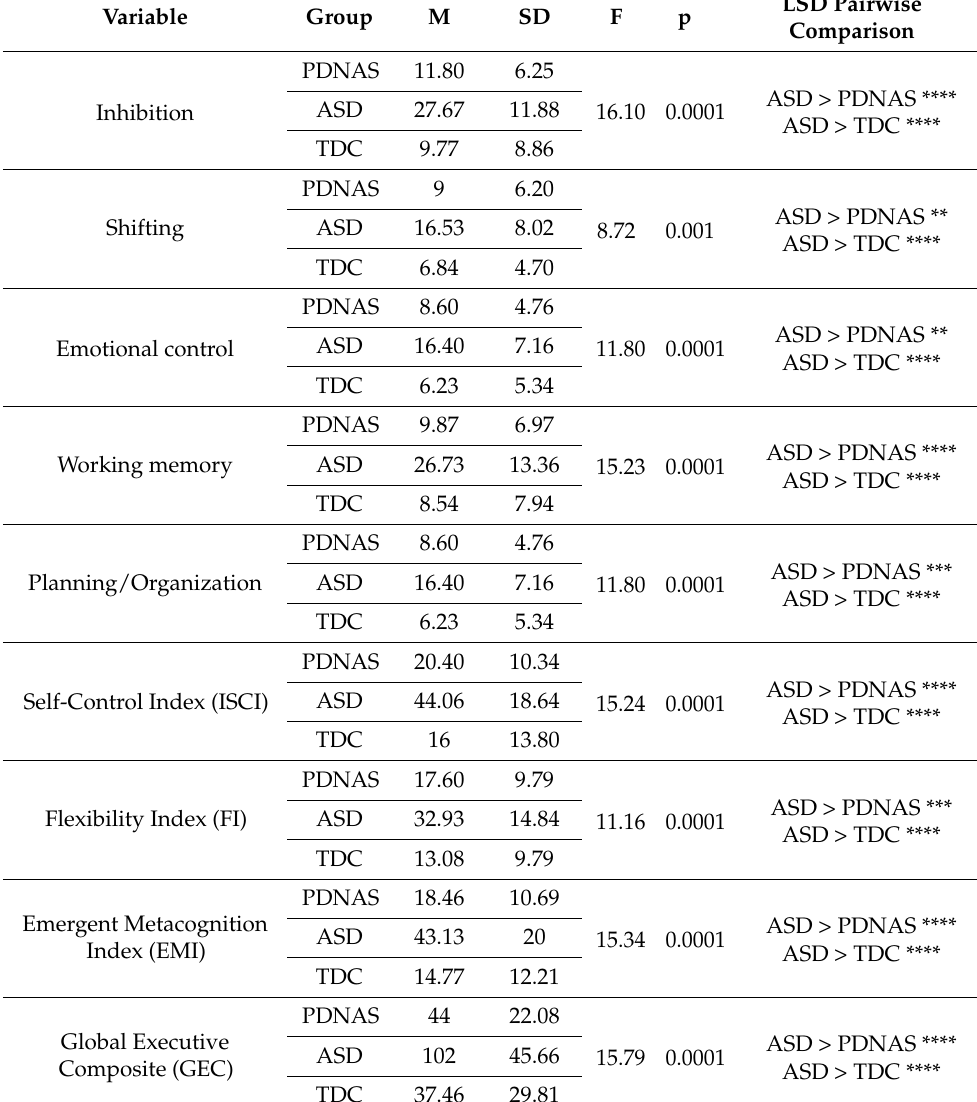
Table 5. Comparison of executive function problems in three